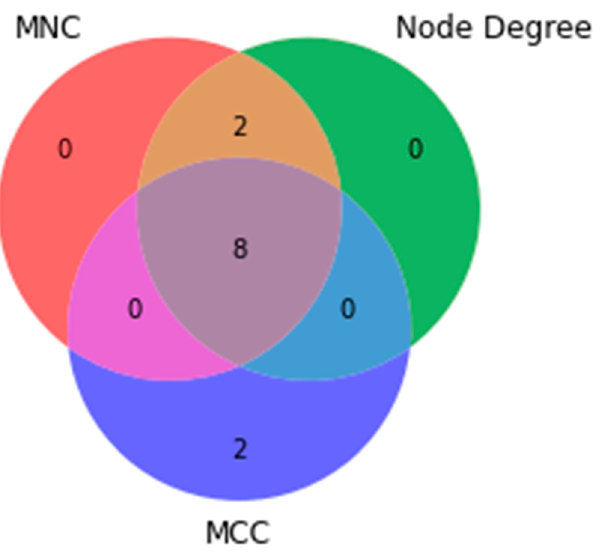
Figure 8. Overlapped hub genes from the MNC, MCC, and node degree methods.